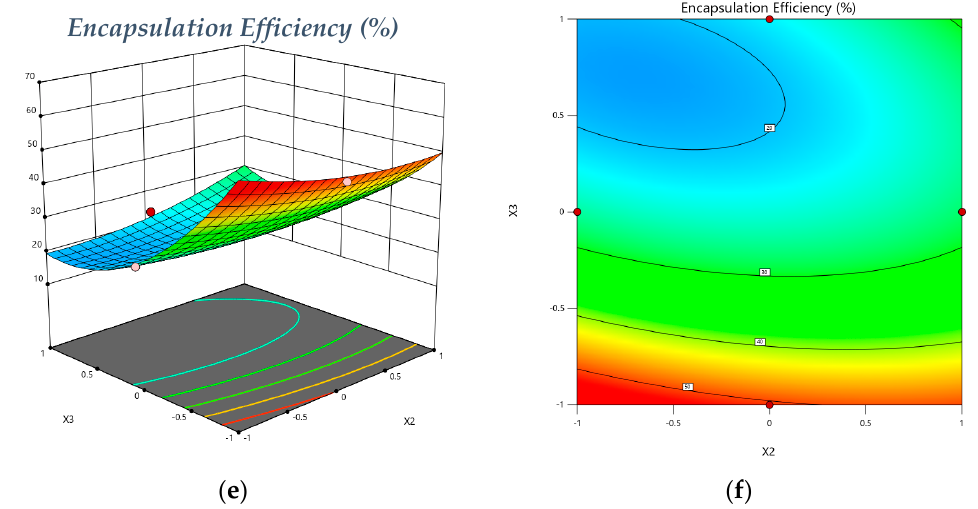
Figure 1. Model graphs: Encapsulation Efficiency. ( a ) Three-dimensional response surface plots showing the effect of variables (X 1 = pH (4.4) and X 2 = Chitosan: Chincho essential Oil ( w / v ) (1: 0.7)) on response (Encapsulation Efficiency), ( b ) 2D contour graph, ( c ) 3D response surface plots showing the effect of variables (X 1 = pH (4.4) and X 3 = Chitosan: TPP ( w / w ) (1:0.46)) on the response variable (Encapsulation Efficiency, ( d ) 2D contour graph, ( e ) 3D response surface plots showing the effect of variables (X 2 = Chitosan: TPP ( w / w ) (1:0.7) and X 3 = Chitosan: TPP ( w / w ) (1:0.46)) on the response variable (Encapsulation Efficiency) and ( f ) 2D contour graph.